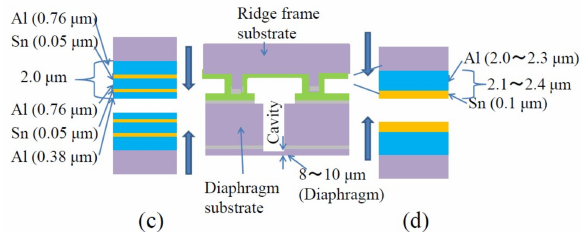
Figure 1. Cross-sectional structure of sample. ( a ) Ridge frame substrate; ( b ) Diaphragm substrate; ( c ) Al bonding layer inserted with thin Sn layers expressed as Al/Sn/Al/Sn/Al//Al/Sn/Al/Sn/Al; ( d ) Al bonding layer capped with thin Sn layer as Al/Sn//Sn/Al.